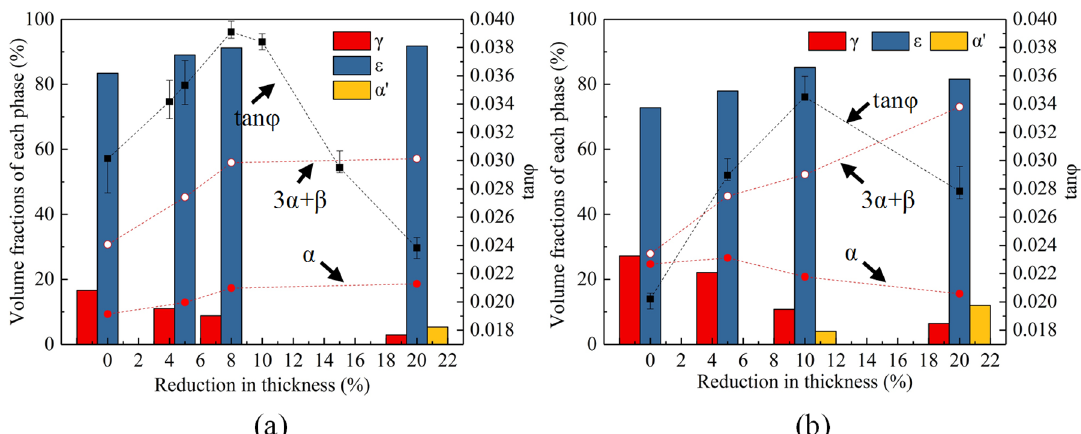
Figure 8. Damping capacities on the strain amplitude of 6×10 -4 , Volume fractions of each phase and SF probabilities in the γ-austenite and ε-martensite: (a) the Fe-19Mn alloy and (b) the Fe-19Mn-8Cr-1Co-0.2Si alloy with different